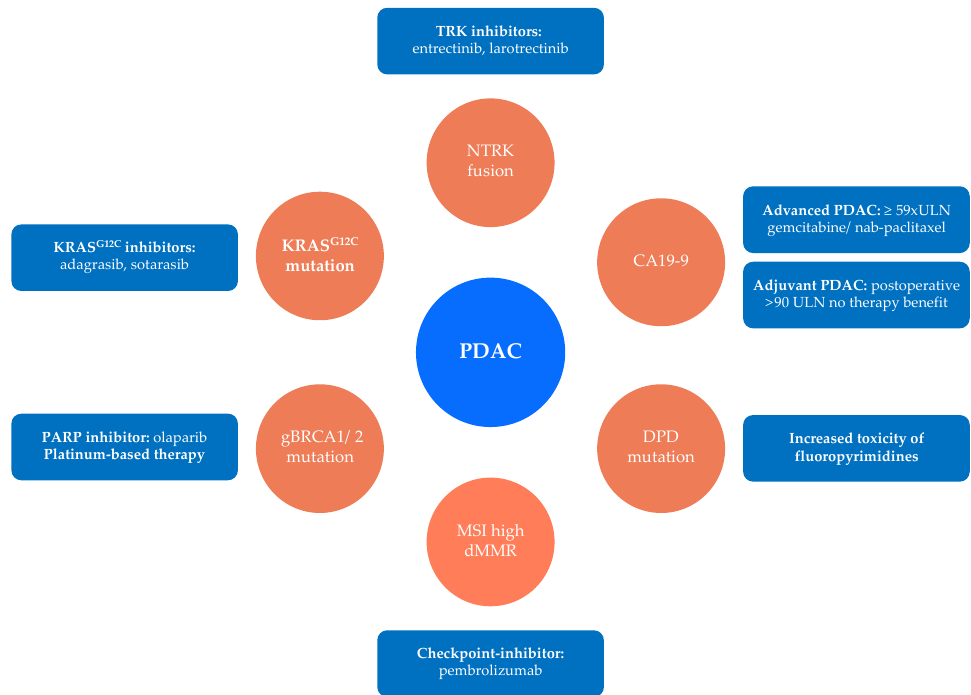
Figure 1. Established biomarkers to direct decision making in pancreatic cancer. Summary of biomarkers which should be considered for therapy decision in PDAC based on sufficient clinical evidence. For advanced PDAC, NTRK, KRAS G12C , germline BRCA1/2, and MSI/dMMR should be tested for targeted therapy. To avoid excessive toxicity, DPD-mutation should be evaluated before therapy with a fluoropyrimidine. CA19-9 should be tested regularly before adjuvant therapy and can guide therapy in advanced disease. (gBRCA1/2 = germline BRCA1/2; MSI = microsatellite instability; dMMR = deficient mismatch repair; DPD = dihydropyrimidine dehydrogenase).